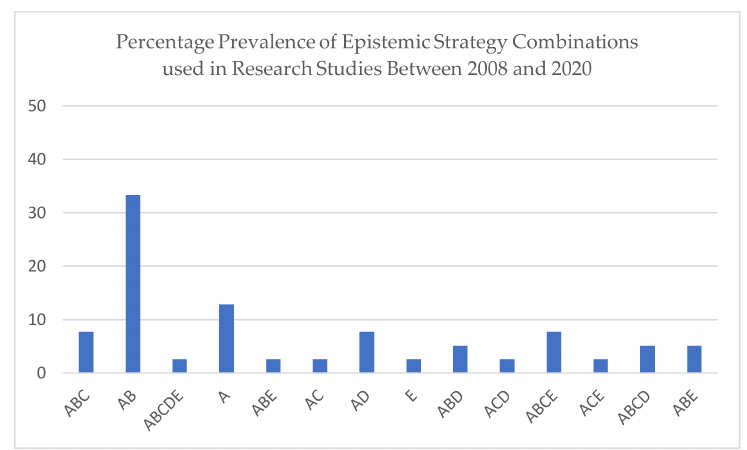
Figure 1. Prevalence of Epistemic Approach Combinations used in Research Studies between 2008 and 2020, where A = Verification, B = Experimental Validation, C = Sensitivity Analysis, D = Inter-model Comparison, E = Justification for use of simulations over conventional experiments.